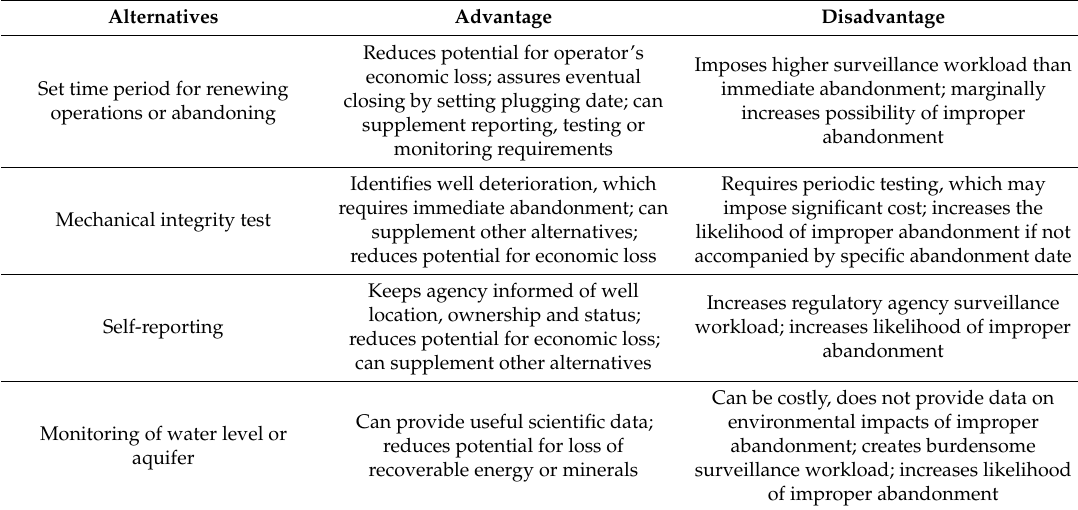
Table 9. Di ff erent alternatives to immediate plugging and abandonment of an injection well